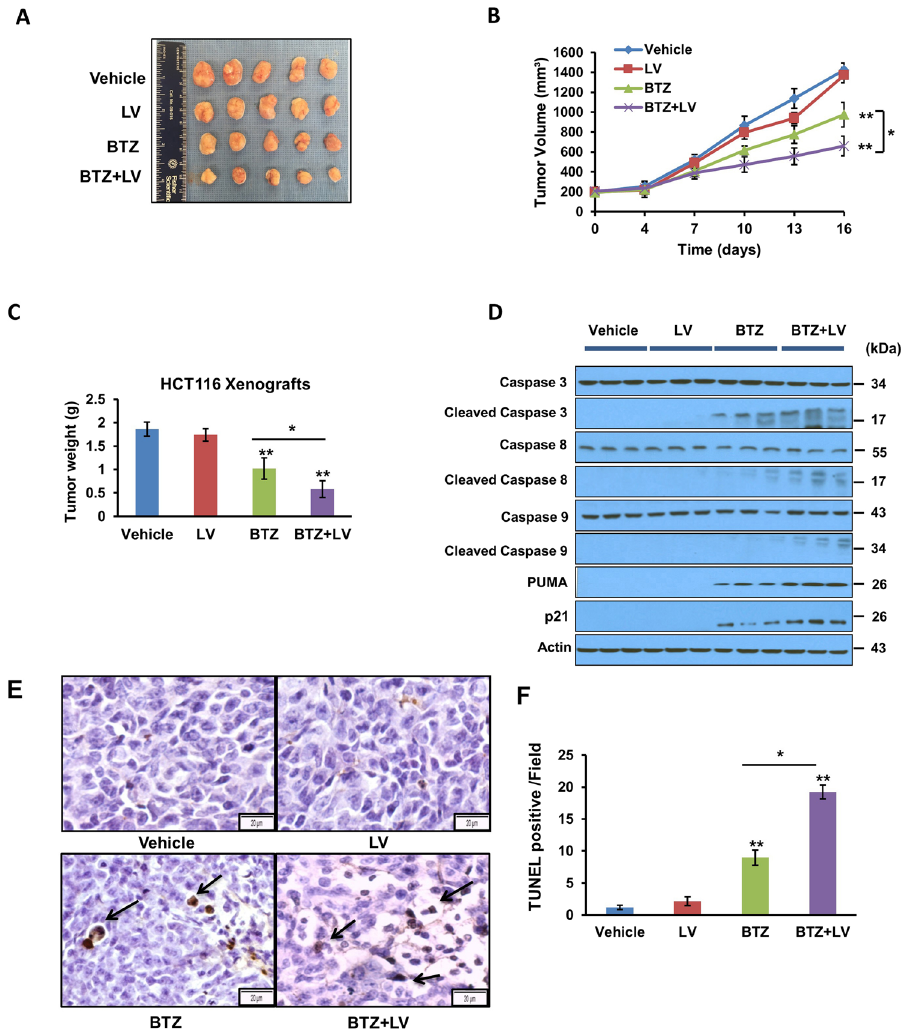
Figure 5. Bortezomib and leucovorin attenuate tumorigenesis of CRC xenografts in mice. HCT116 cells (5 × 10 5 per mouse) were subcutaneously injected into the right flank of NSG mice. When the tumors reached 200 mm 3 , mice (n = 5 per group) were arbitrarily assigned to one of four groups for treatment with vehicle, 0.5 mg/kg bortezomib, 80 mg/kg leucovorin, or the combination twice a week by intraperitoneal injection. ( A) Gross tumors at day 16 post treatment. ( B ) Tumor volumes during treatment were measured using a caliper. Data are presented as the mean tumor volume with SEM. ( C ) Tumor weights at day 16. ( D ) Western blot analyses of caspases and their activation (n = 3 representative tumors of 5). ( E ) TUNEL staining to detect apoptosis of tumor cells. A representative image is shown for each group. Arrows points to apoptotic cells. Scale bar = 20 µ m. ( F ) Percentage of TUNEL-positive tumor cells per microscopic field. A total of 10 fields was counted for each group. The percentage was calculated as number of cellular nuclei staining positive divided by the total number of